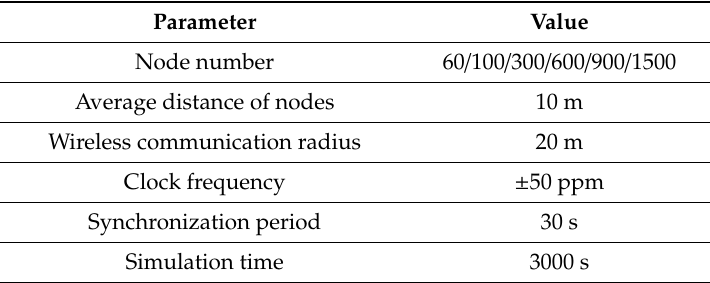
Table 1. Simulation parameters in